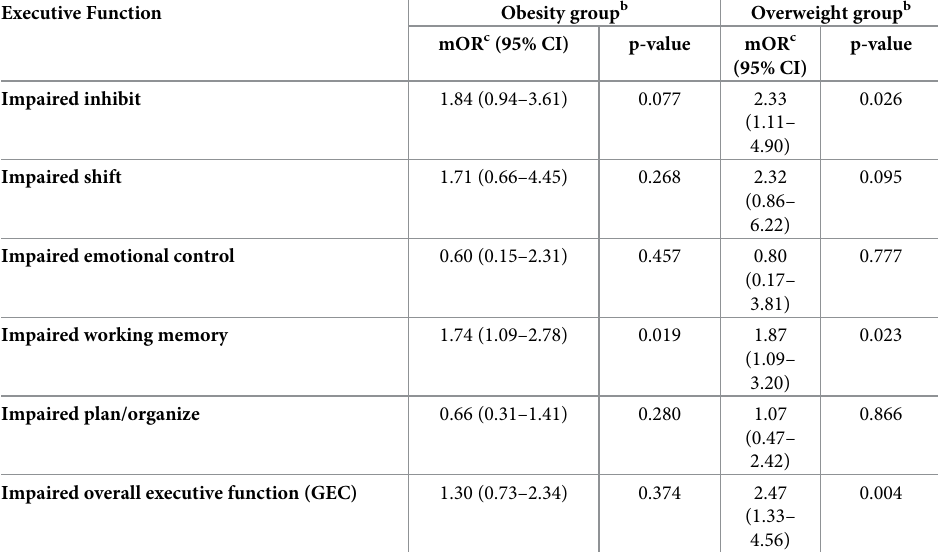
Table 3. Multivariable polynomial logistic regression analysis of weight status outcome and executive function subscales/global executive function scale a (N =